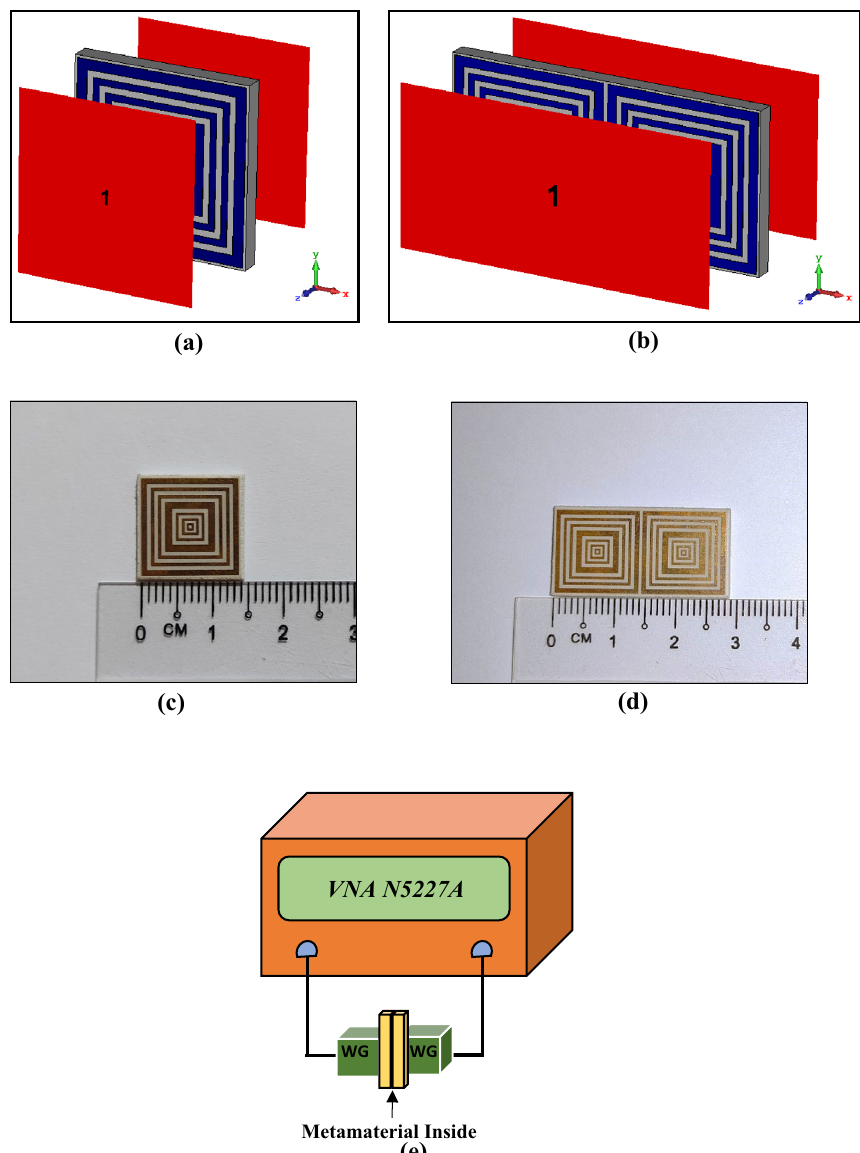
Figure 2. Numerical simulation geometry and fabrication measurement setup: ( a ) SQM unit cell simulation, ( b ) 1 × 2 SQM array simulation, ( c ) fabricated SQM unit cell, ( d ) fabricated 1 × 2 SQM array, ( e ) metamaterial measurement setup of VNA